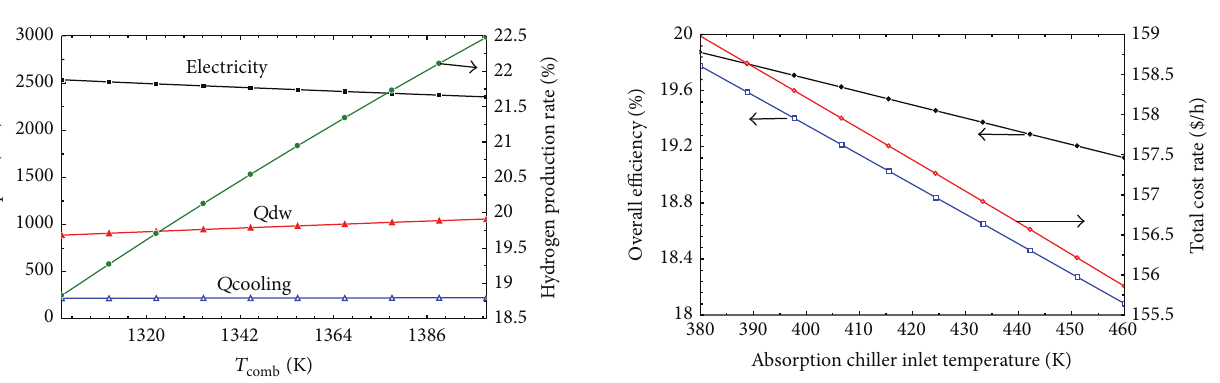
Figure 6: The impact of the combustion temperature on the main outputs. 𝑄 dw: domestic water heater. 𝑄 cooling: absorption chiller output.